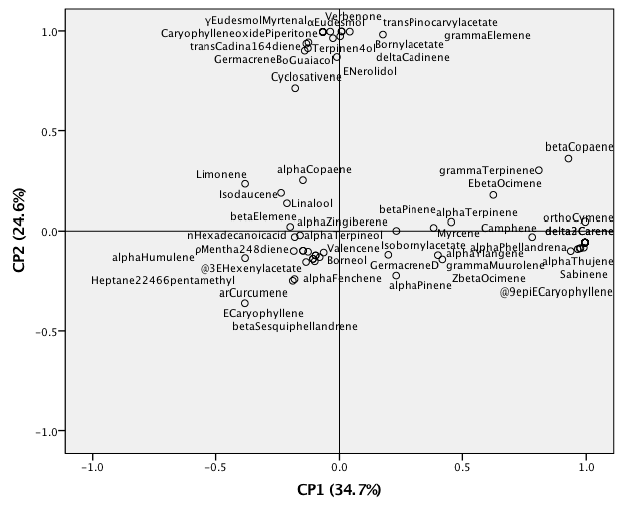
Figure 2. PCA loading plots revealing the compounds present in Z. kerrii.